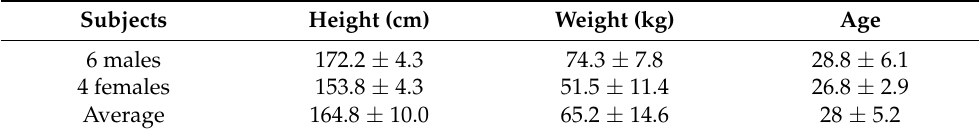
Table 2. Number of participants with the corresponding standard deviation.